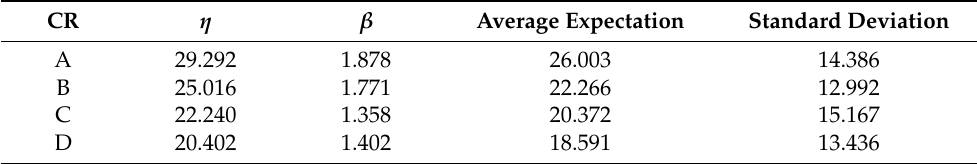
Table 5. Results of parameter estimation for the Weibull